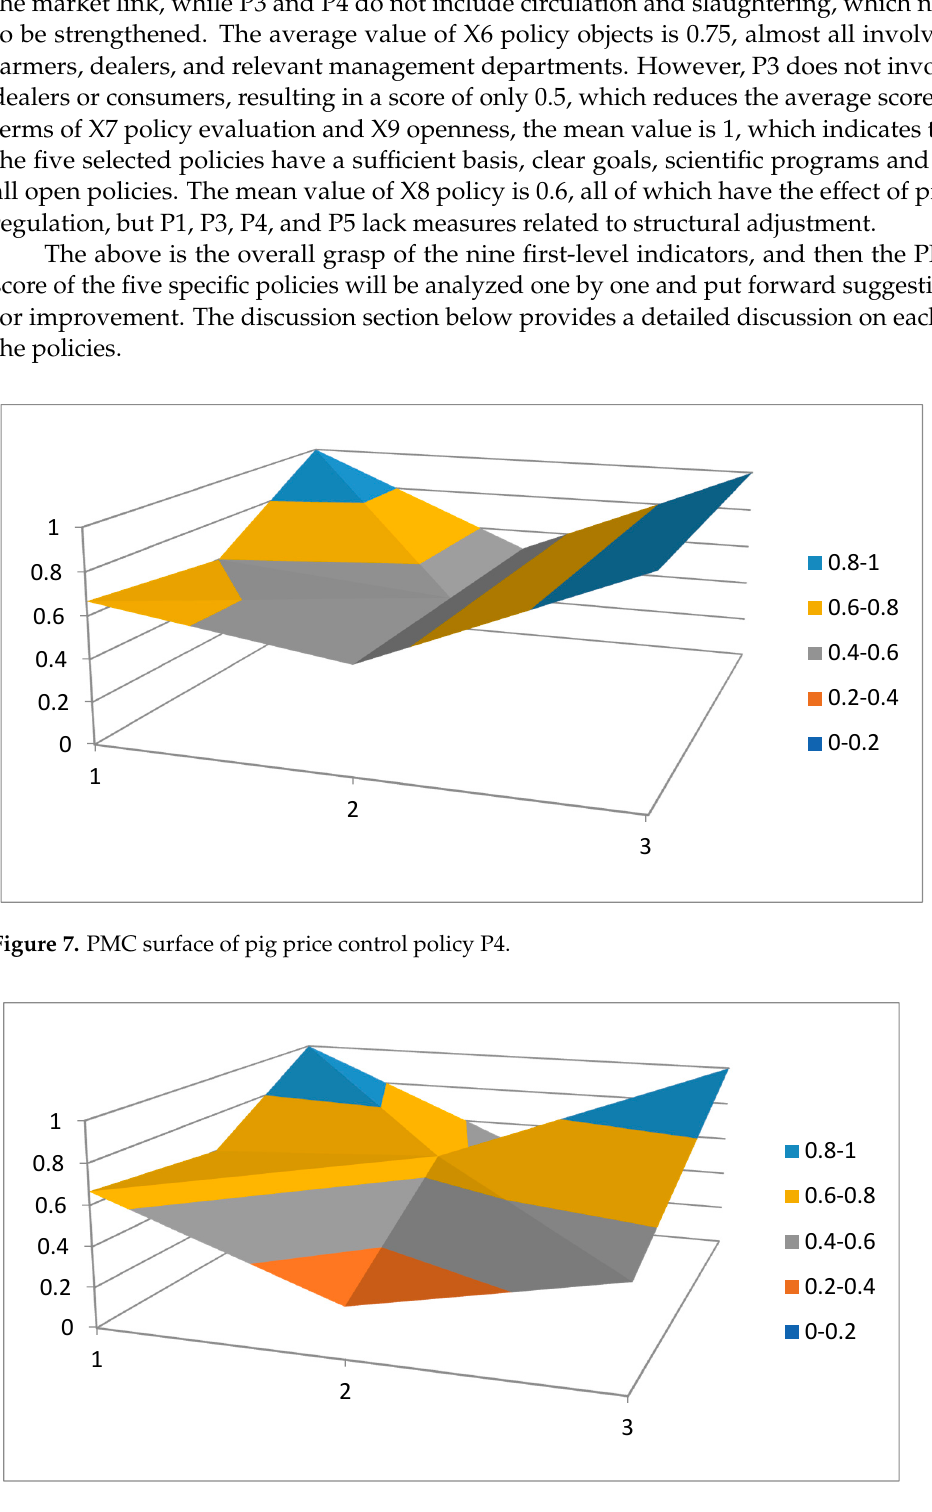
Figure 8. PMC surface of pig price regulation policy P5.